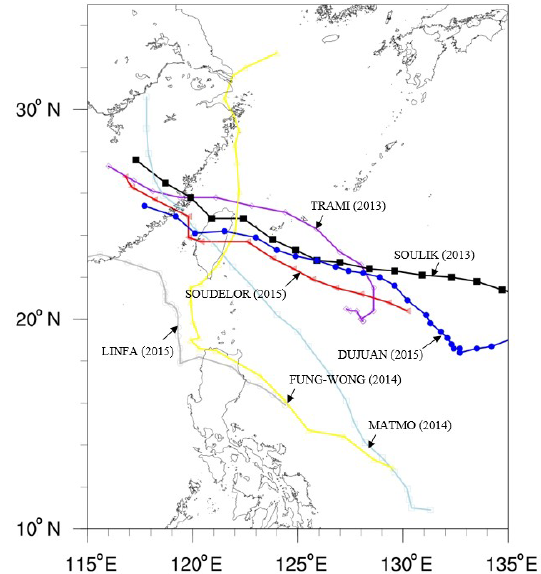
Figure 5. Location of the island of Taiwan, seven typhoons during 2013–2015, and their observed tracks.